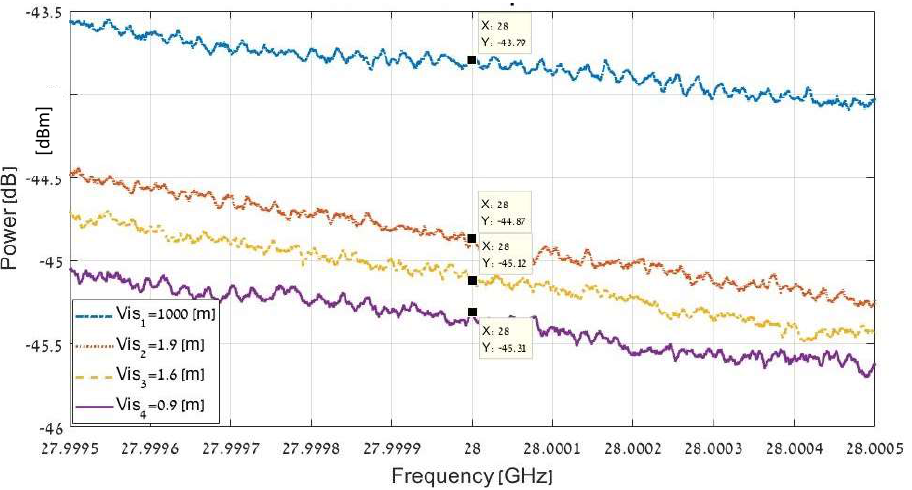
Figure 11. Received signal power at 28 GHz for variable fog visibility.